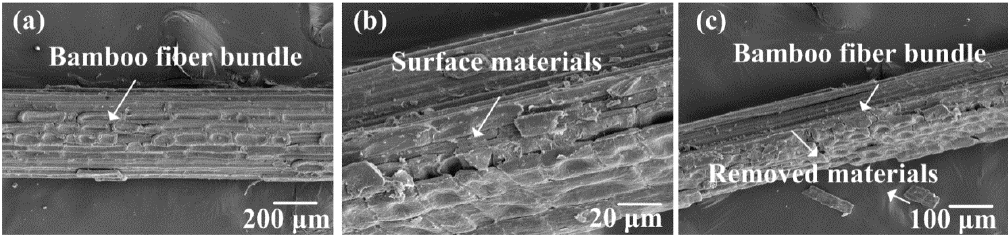
Figure 4. SEM images of the surface of the untreated bamboo fiber bundles.